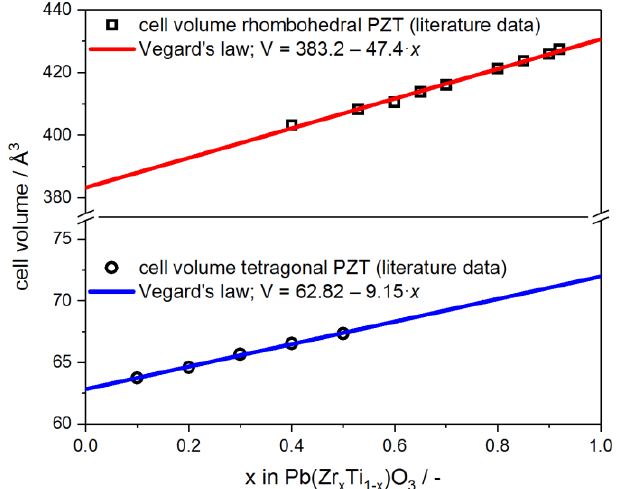
Figure 4. Powder XRD patterns for PZT-polymer and PZT-PDC composites together with the corresponding Rietveld fits. ( a ) The variation in the heat treatment temperature at a constant PZT load of 50 vol.%; ( b ) the variation in the PZT volume fraction for a pyrolysis temperature of 1250 °C.